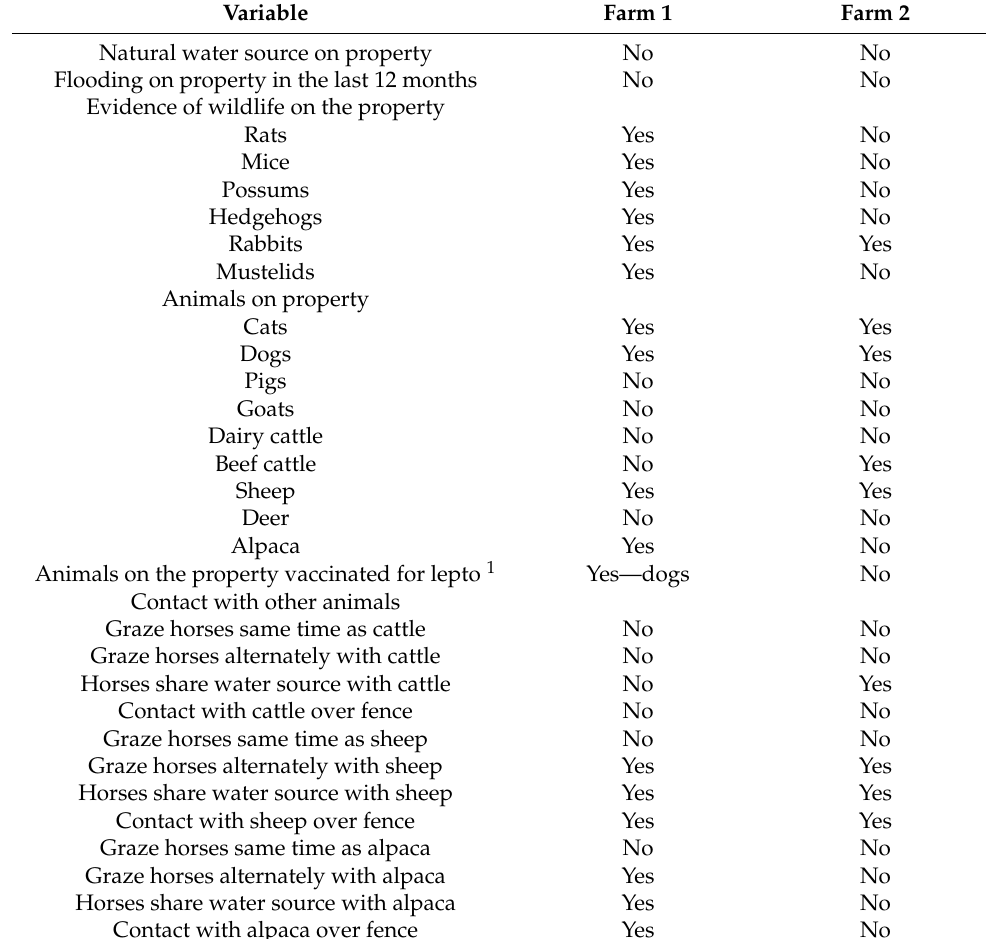
Table 2. Results of the farm questionnaire conducted with the owners of the farms where horses were located during sampling for leptospiral antibodies, which were located near to outbreak of leptospirosis in alpacas. Farm 1 Farm